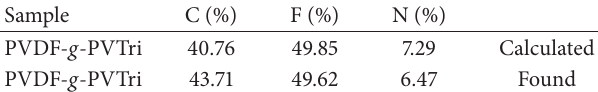
Table 1: Azole content of VTri found from EDS results. Sample C (%) F (%) N (%) PVDF- g -PVTri